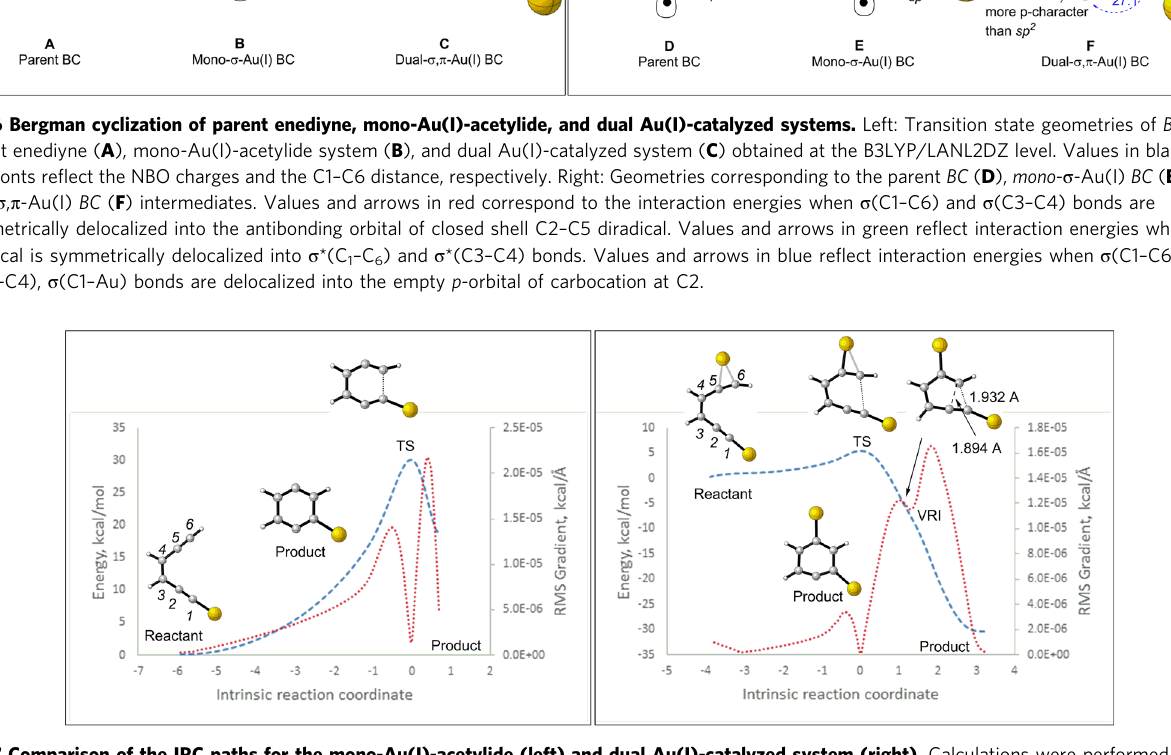
Fig. 7 Comparison of the IRC paths for the mono-Au(I)-acetylide (left) and dual Au(I)-catalyzed system (right). Calculations were performed at the B3LYP/LANL2DZ level. The dashed blue line and dotted red line correspond to energy changes and RMS gradient along the intrinsic reaction coordinate. VRI corresponds to “ Valley Ridge In fl ection ” 51 – 55